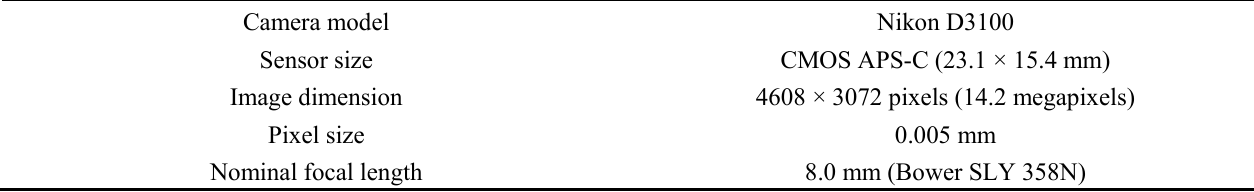
Table 1. Technical specifications for the image acquisition